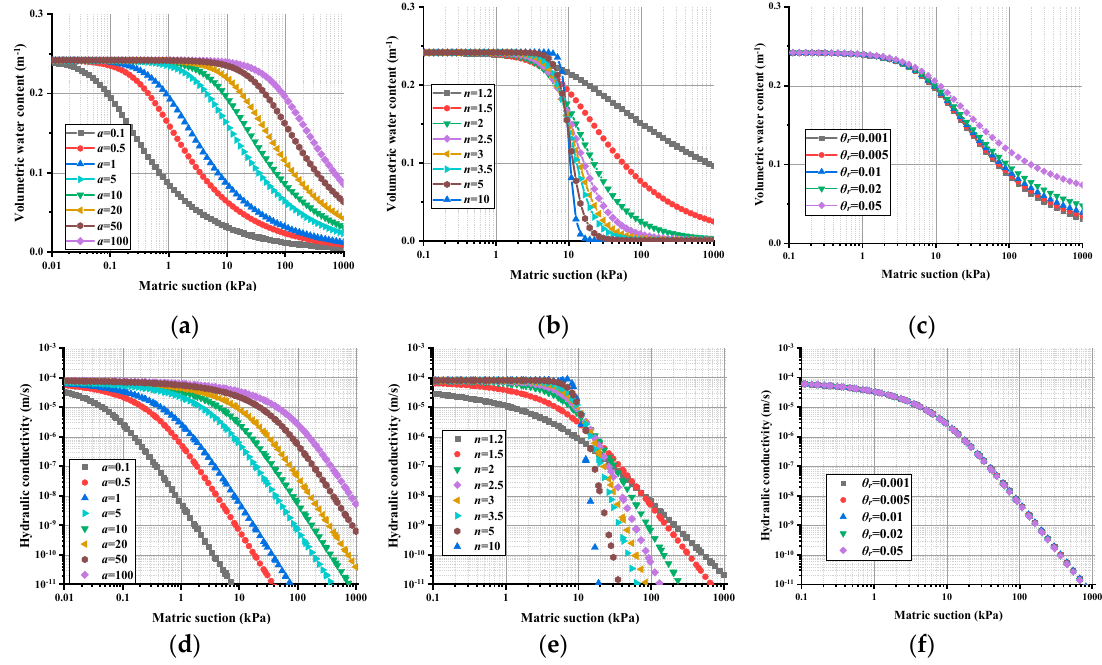
Figure 5. Water retention curves and hydraulic conductivity curves: ( a ) Condition 1 of the water retention curve; ( b ) Condition 2 of the water retention curve; ( c ) Condition 3 of the water retention curve; ( d ) Condition 1 of the hydraulic conductivity curve; ( e ) Condition 2 of the hydraulic conductivity curve; ( f ) Condition 3 of the hydraulic conductivity curve.